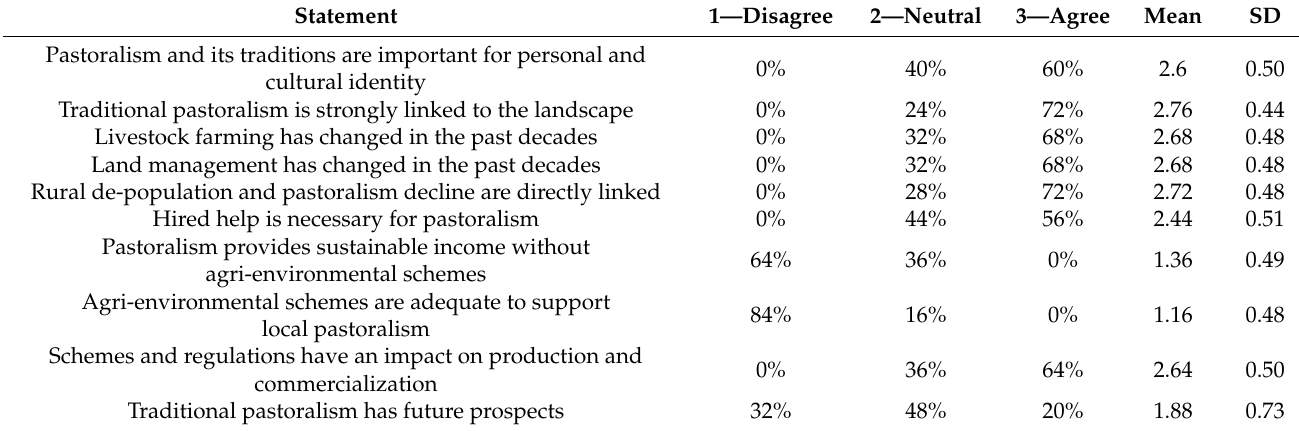
Table 3. Responses to interviews. Answer scale: 1 = disagree, 2 = neutral, 2 = agree. Frequency of occurrence of the responses is reported in percentages. Mean score and standard deviation are also